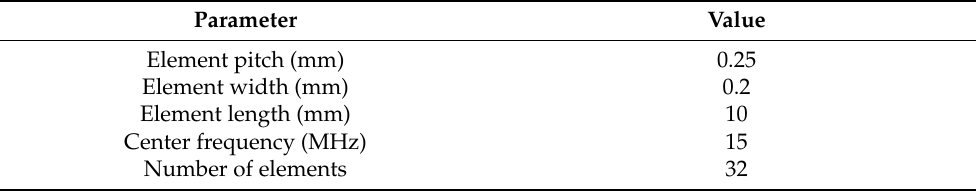
Figure 5. Linear array ultrasonic transducer. ( a ) Ultrasonic transducer and ( b ) array distribution diagram. Table 1. Parameters of Phased Array.